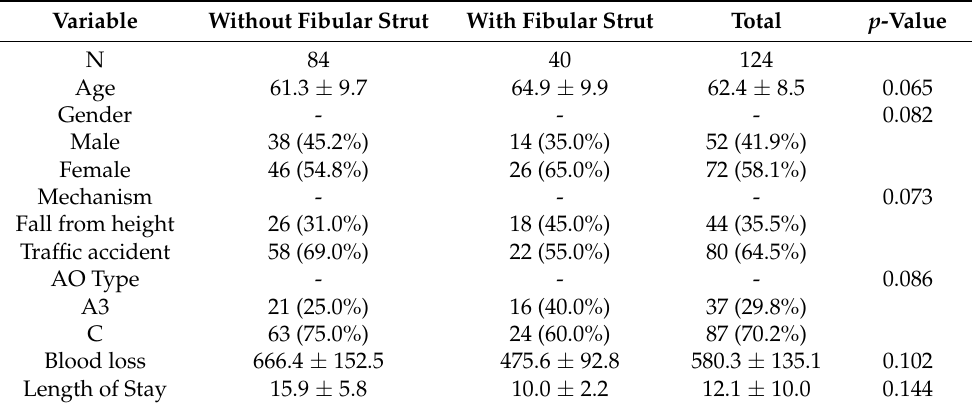
Table 1. Demographic data of the included patients ( n =